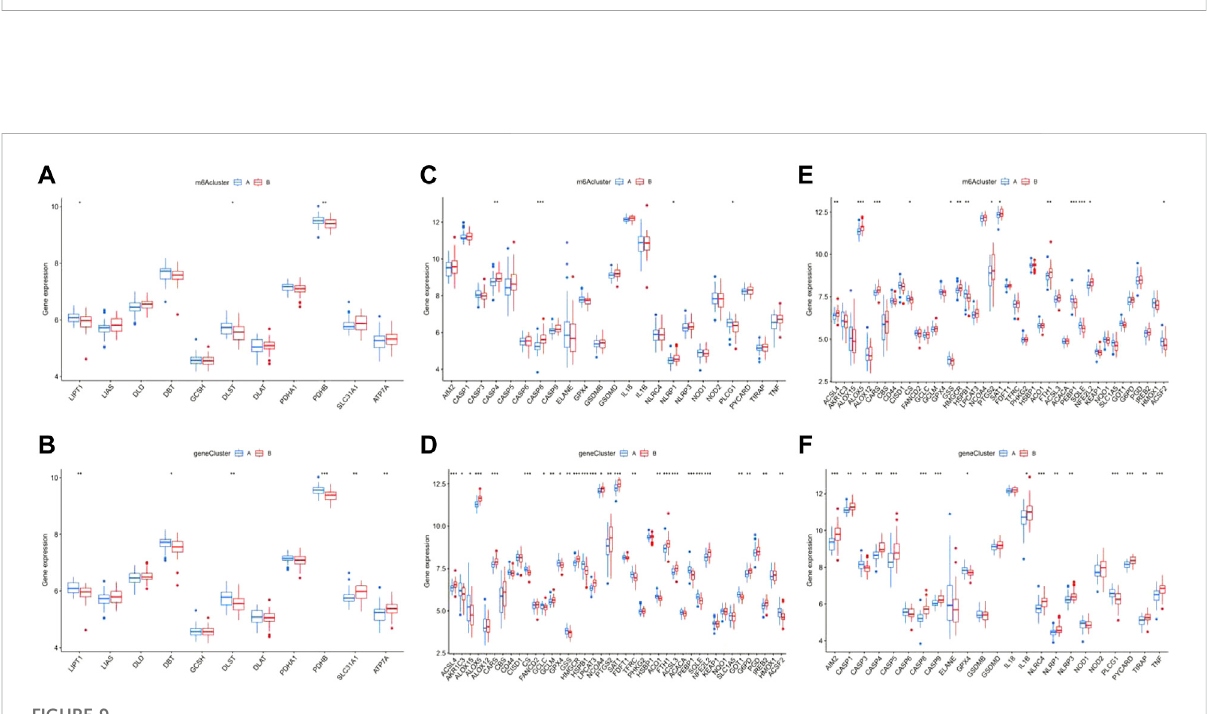
FIGURE 9 Correlation between the expression of cuproptosis, pyroptosis, and ferroptosis in different m6A clusters and gene clusters in epilepsy patients. The difference of expression of cuproptosis in different m6A clusters (A) and gene clusters (B) . The same difference analysis of pyroptosis (C,D) and ferroptosis (E) , (F) * p < 0.01, ** p < 0.001, *** p <